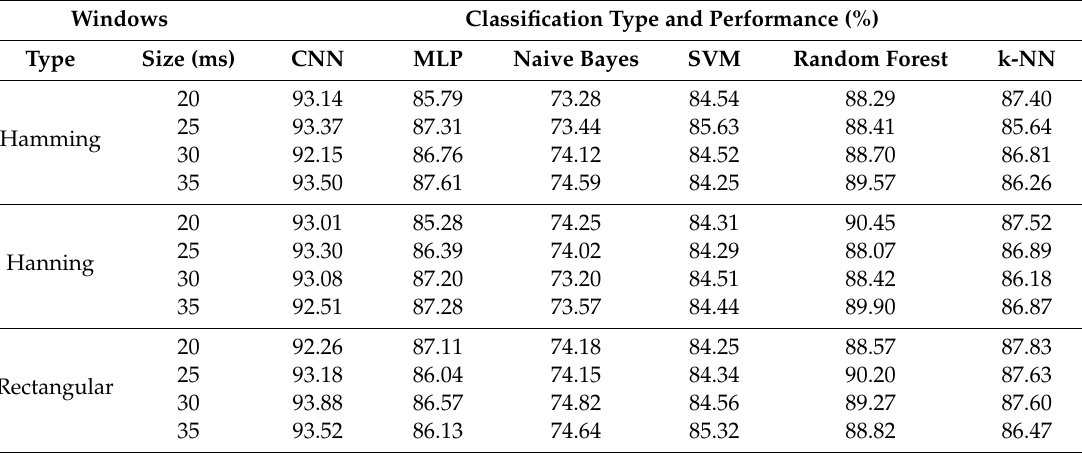
Table 8. Performance accuracy for female speakers based on GRU + EZDMFCC.